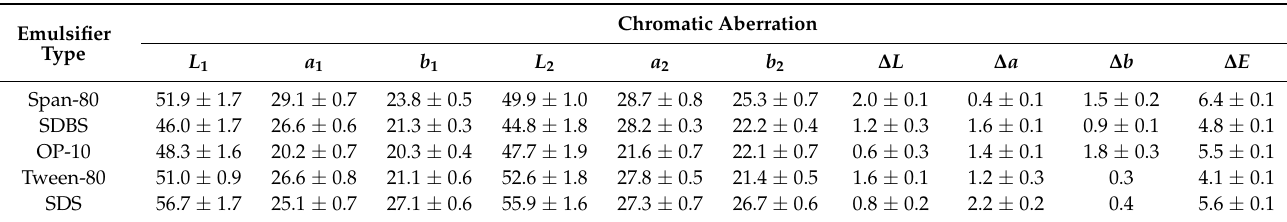
Table 4. Effect of emulsifier on chromatic aberration of coating film.